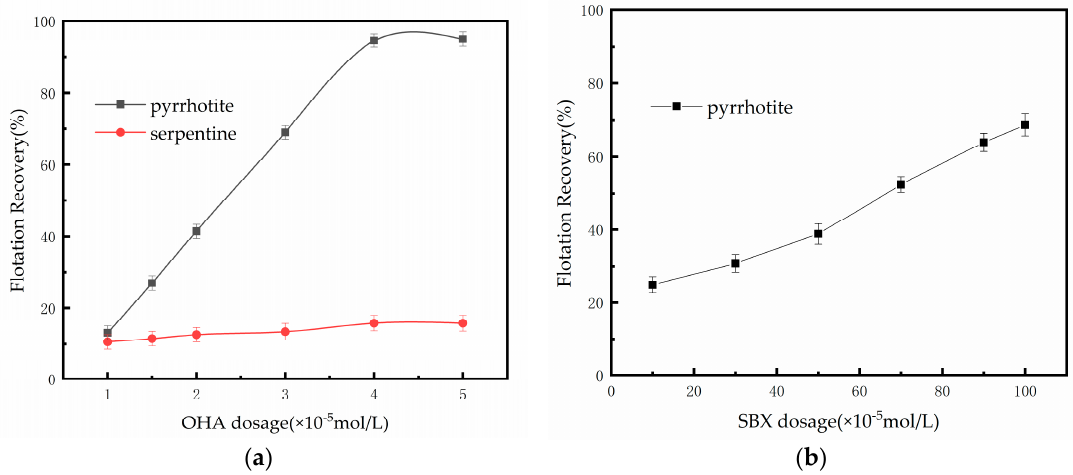
Figure 3. Effect of the collector dosage (( a ): OHA, ( b ): SBX) on the flotation of pyrrhotite (ET = 24 h).